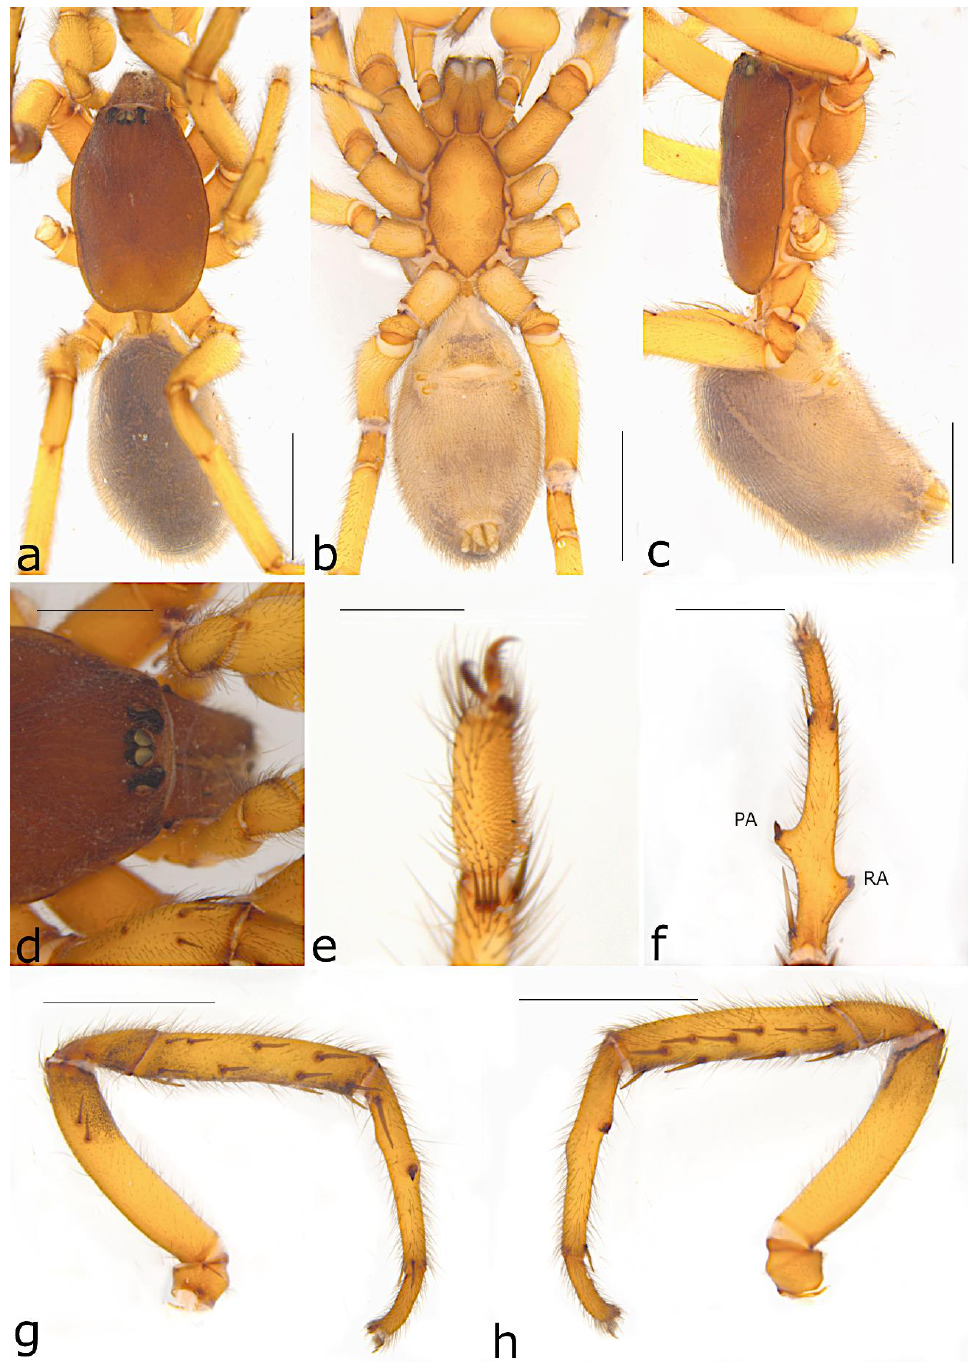
Figure 62. Ariadna una sp. nov. ♂ holotype (SAMA NN10578) from near Illintjitja (SA): ( a ) habitus, dorsal view; ( b ) same, ventral view; ( c ) same, lateral view; ( d ) eyes, dorsal view; ( e ) left metatarsus IV, preening comb, retrolateral view; ( f ) left leg I, ventral view; ( g ) same, prolateral view; ( h ) same, retrolateral view. Scale bars ( a – c ) = 2 mm, ( d ) = 1 mm, ( e ) = 0.5 mm, ( f ) = 1 mm and ( g , h ) = 2 mm.